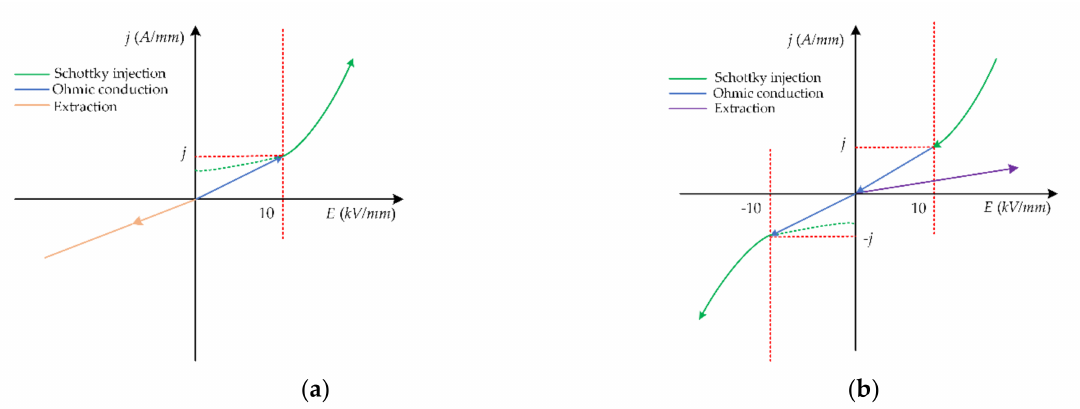
Figure 6. Conduction mechanism during the applied DC voltage shown in Figure 3 at the anode: ( a ) Stage I; ( b ) Stage II and the application of stable external voltage − U 0 in Stage